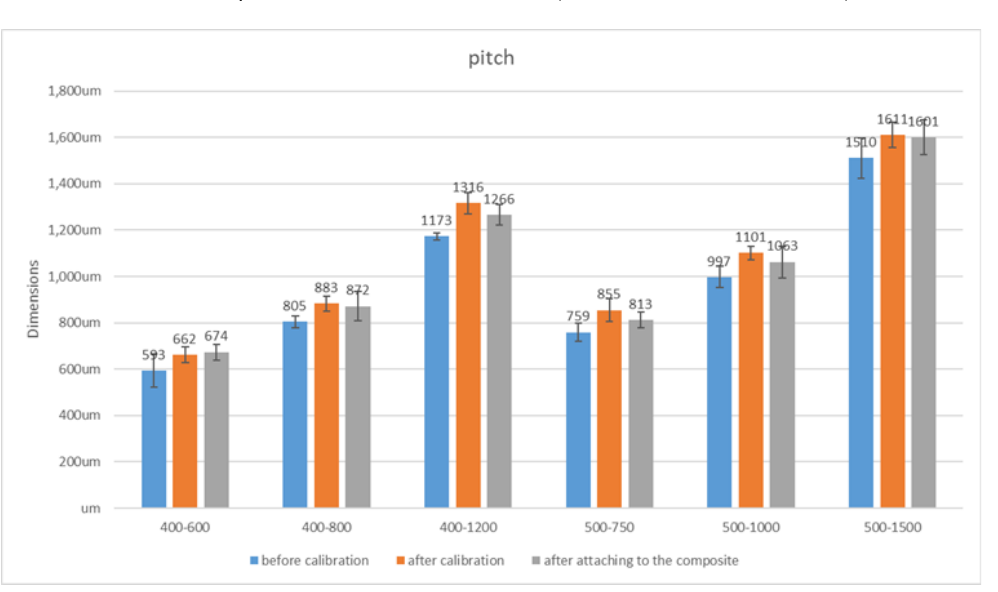
Figure 6: The samples' pitches were measured using a stereomicroscope. The original designs were later modified by adding 200 um for the diameters. This was done due to the limitations of the printer and to make the diameter close to the intended